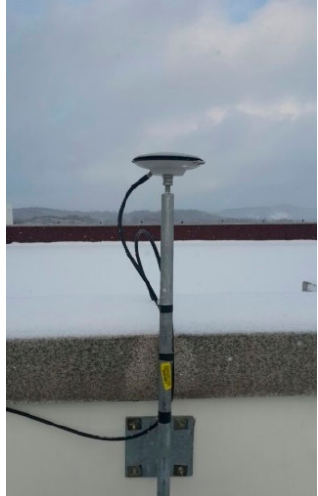
Figure 7. GPS antenna mounted on the side wall of a